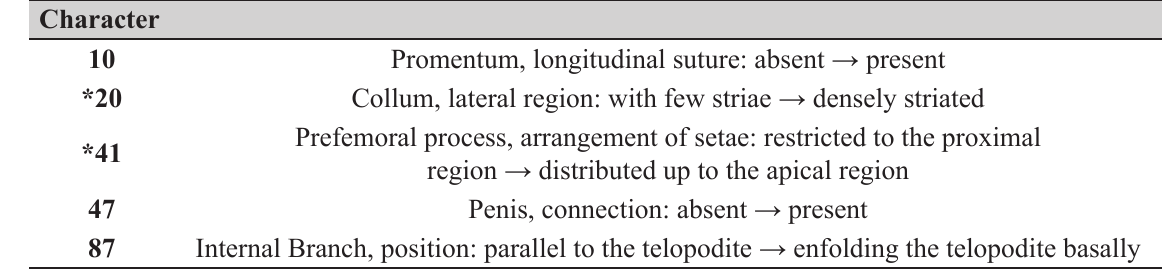
Table 3. List of characters recovered to support the clade Pseudonannolene Silvestri, 1895 from the cladistic analysis (see Fig. 4). Characters marked with an asterisk (*) are homoplastic synapomorphies.